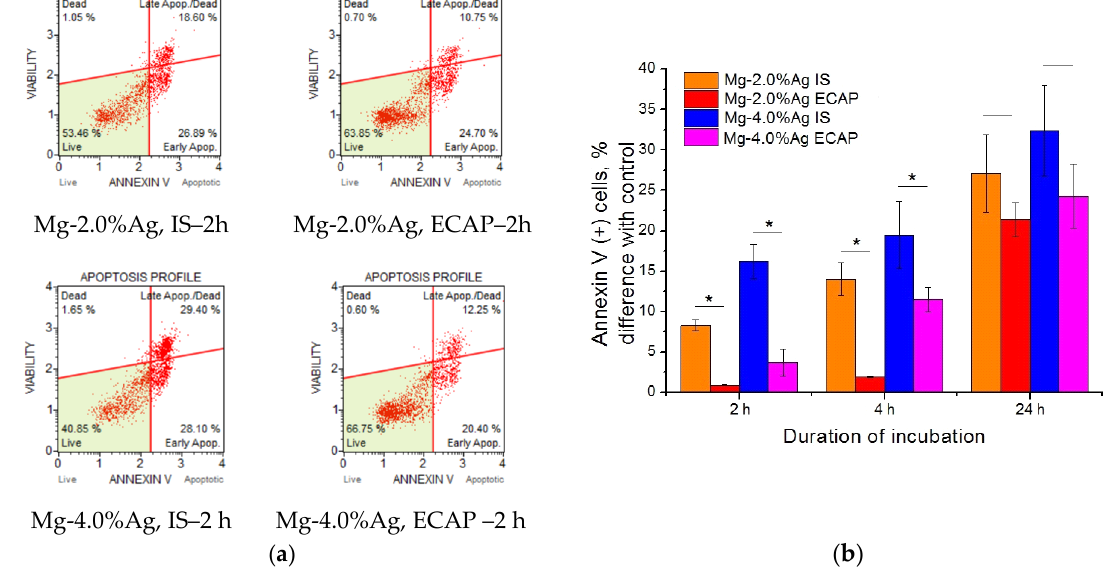
Figure 8. Increase of Annexin V ( + ) cells concentration after incubation with samples of Mg-2.0%Ag and Mg-4.0% Ag alloys in the initial state (IS) and after ECAP compared to the control ( a ) Annexin V(+) cells concentration ; ( b ) difference with control) (* p < 0.05).